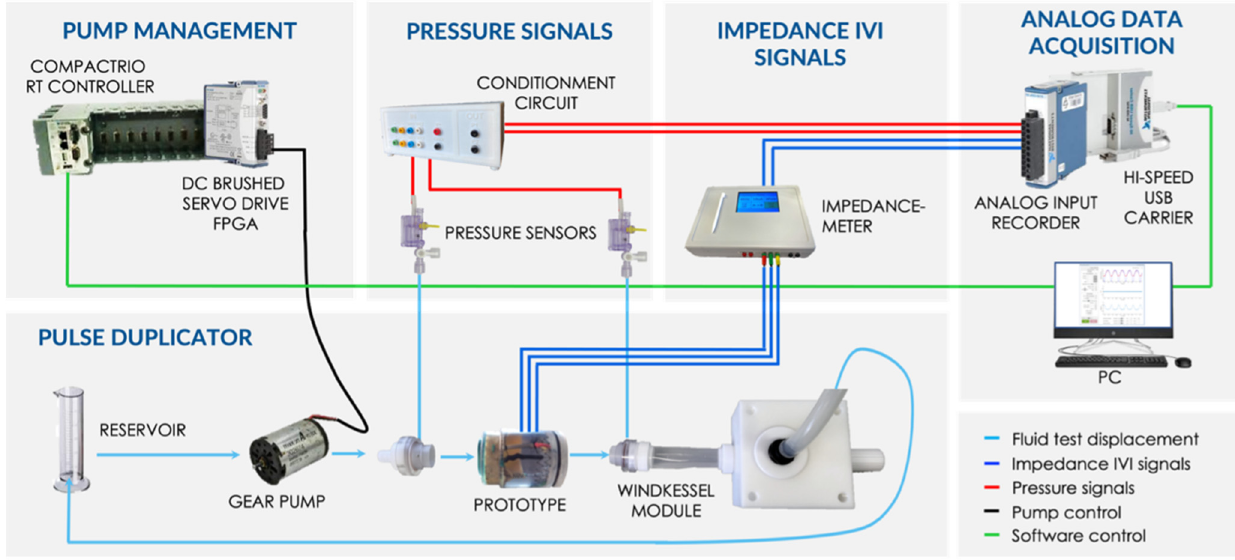
Figure 8. Schematic representation of the circulatory mock ‐ loop platform for in vitro testing. The pulsatile displacement of the circulatory fluid (NaCl 0.9% in aqueous solution)